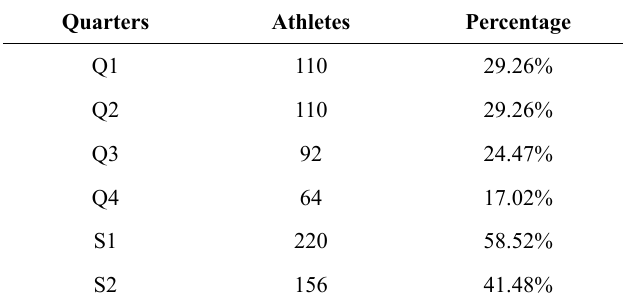
Table 1 – Absolute values for the birthdates of men futsal athletes.